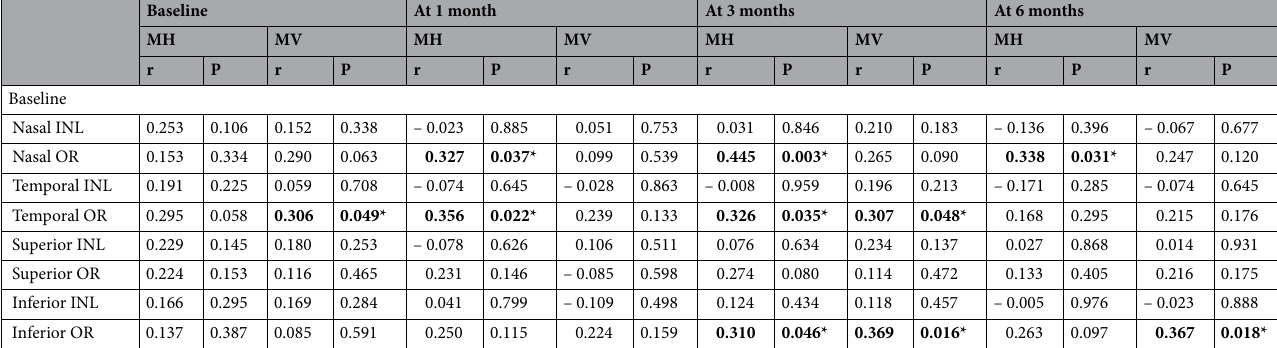
Table 2. Correlations between M-CHARTS scores and preoperative inner nuclear layer and outer retinal thickness. Spearman’s rank correlation coefficient was used to determine the significance of the correlations. MH horizontal score of M-CHARTS, MV vertical score of M-CHARTS, INL inner nuclear layer thickness, OR outer retinal thickness. Significant P value are indicated by asterisk (*). Significant values are in bold.